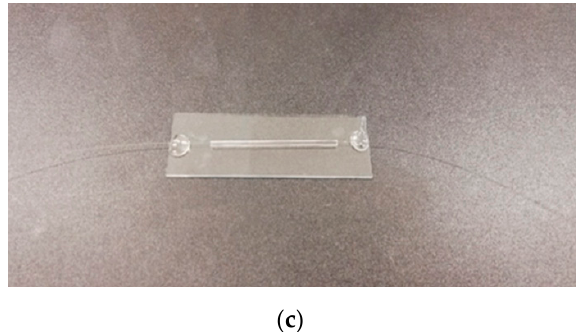
Figure 5. ( a , b ) Schematic of arrangements for protection taper with possibilities of alkanes and nanoparticle cladding application, and ( c ) cross-section of a sample.